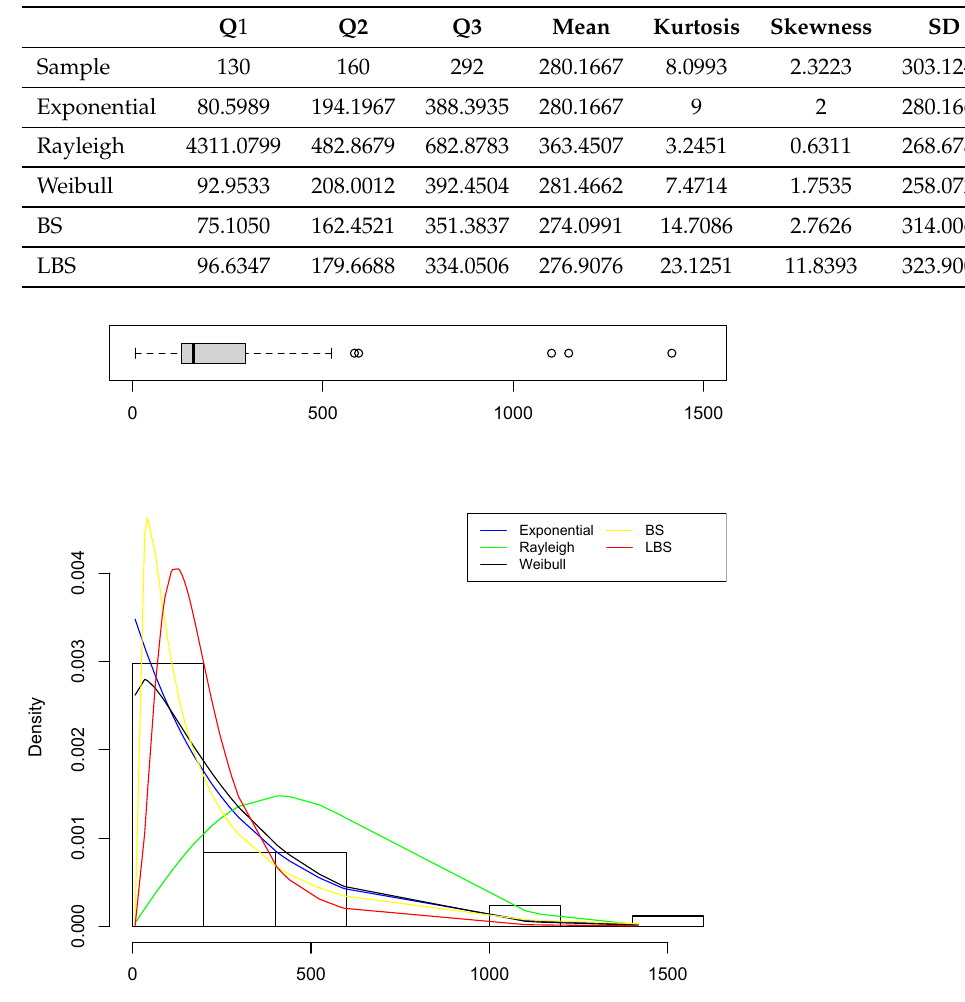
Table 5. EDA outcomes based on Head and Neck Cancer data.